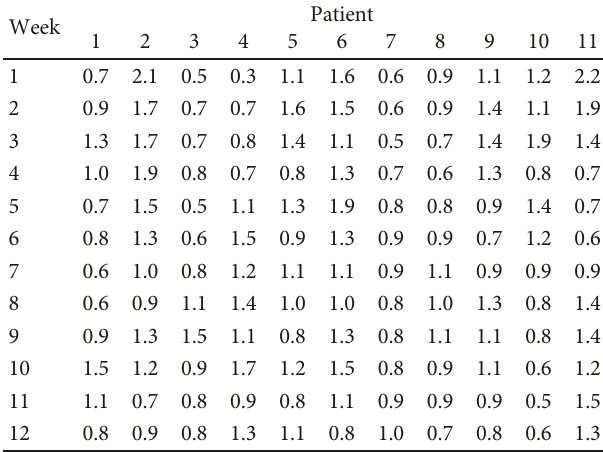
Table 1: Weekly ketone measurements through a 90-day low- carbohydrate diet in women ( n = 11